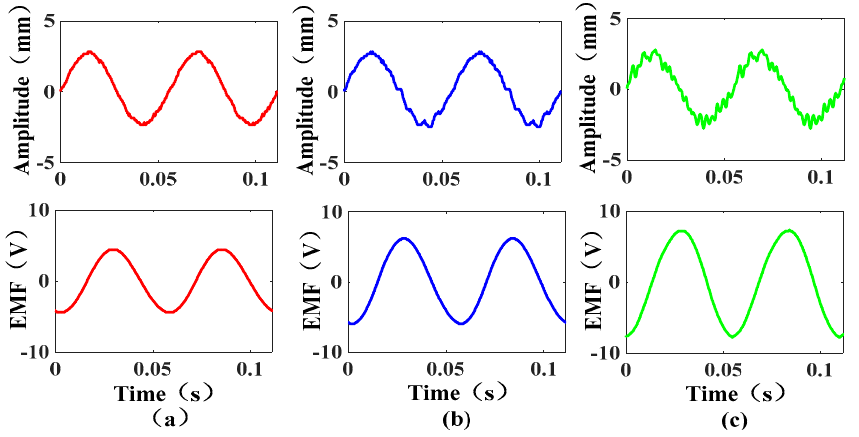
Figure 14. Effect of the number of coil turns on the EMF:( a ) 188; ( b ) 1130; ( c )